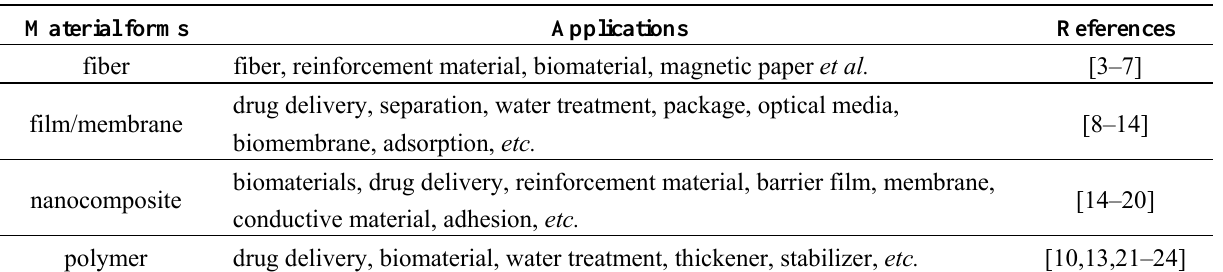
Table 1. Applications of cellulose in different forms illustrated in